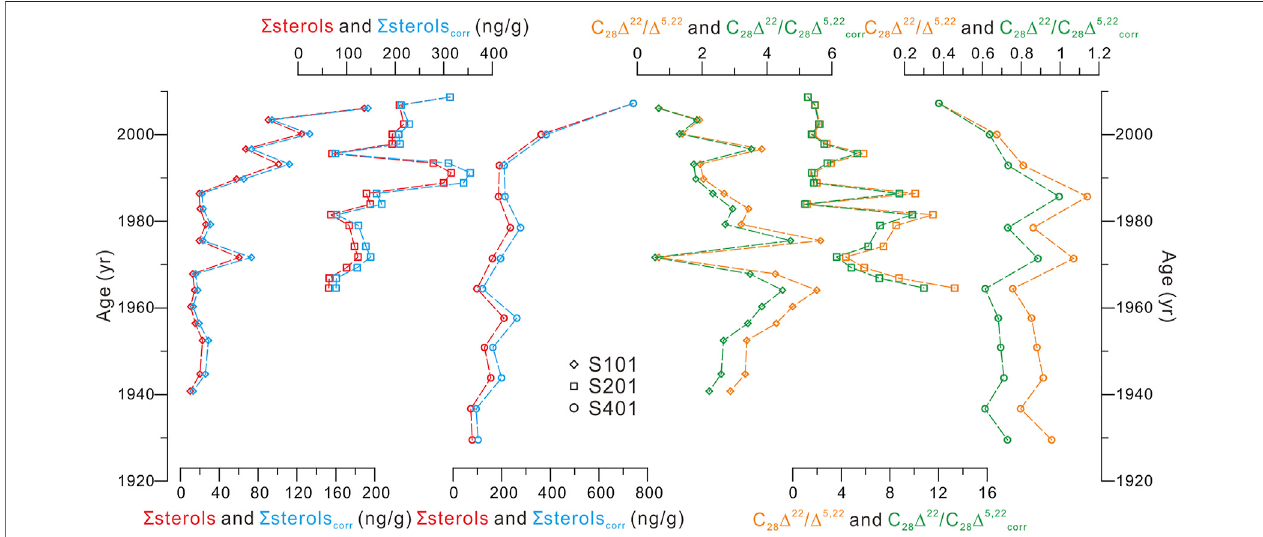
FIGURE 6 | Comparison between (cid:4) sterols(red curves) and (cid:4) sterols corr (blue curves), and between C 28 Δ 22 / Δ 5,22 (orange curves) and C 28 Δ 22 / Δ 5,22 corr (green curves) in the three cores. The C 28 Δ 5,22 corr pro fi les were calculated using the method by Canuel and Marten (1996), as the similar approach for (cid:4) sterols corr .